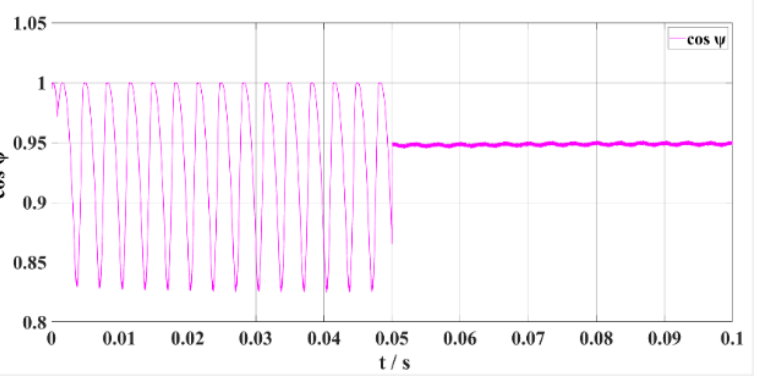
Figure 15. Mode 1 grid-connected power factor.